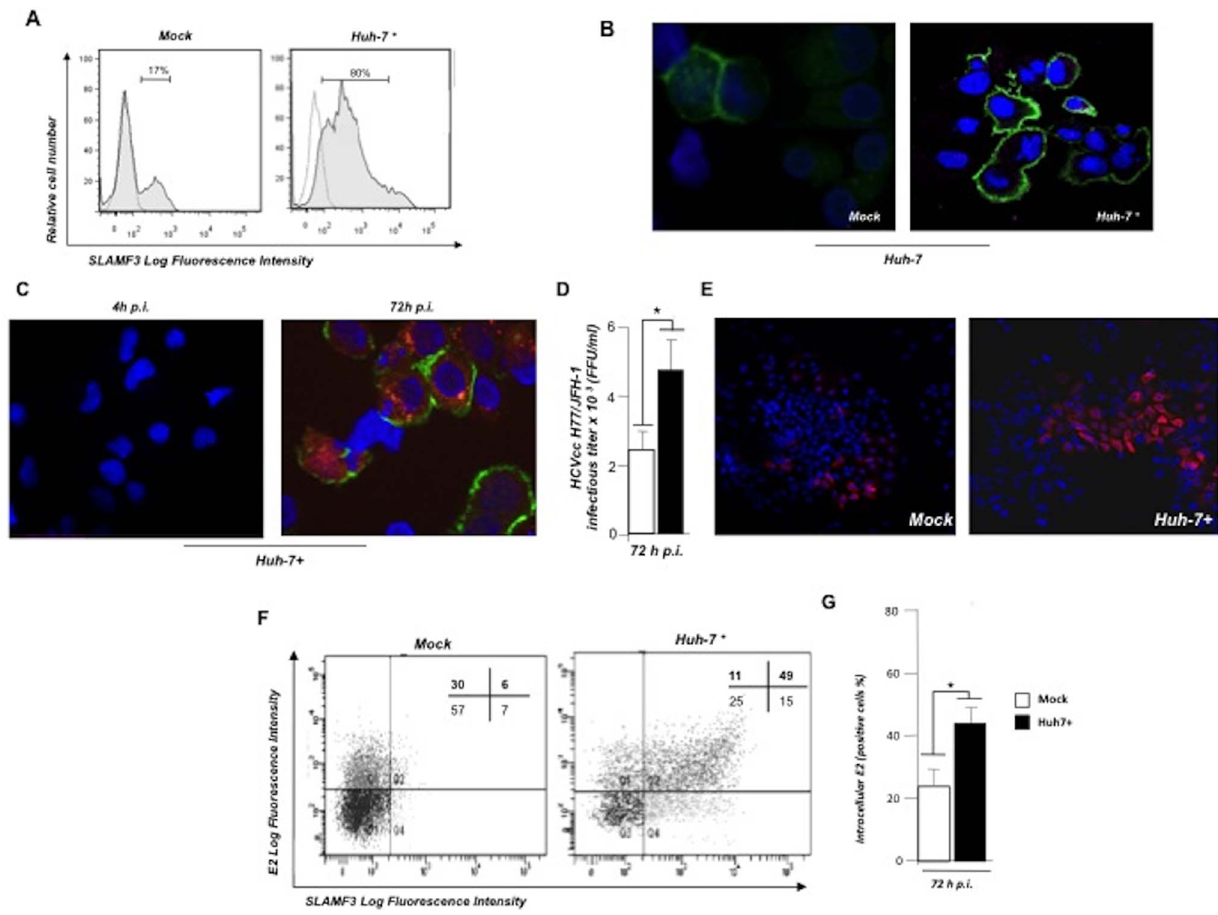
Figure 4. SLAMF3 over-expression increases hepatocyte permissiveness to HCV. Huh-7 cells were transfected with empty vector pBud (mock) or human SLAMF3 (to yield Huh-7 + cells) and incubated with HCVcc. (A) SLAMF3 expression was analyzed by flow cytometry (HLy9.1.25 clone) and (B) visualized by confocal microscopy in one out of three experiment. Unshaded histograms show the isotype-matched control (Co) and shaded histograms show SLAMF3 expression). (C, D, E) Infection was assessed at 4 and 72 h p.i. as the number of FFUs and (F and G) by flow cytometry analysis; (C) intracellular E2 (stained red) were measured at 4 h and 72 h p.i. Green staining corresponds to the SLAMF3 expression. One of three representatives independent experiments is shown. (D) The HCV permissiveness of Huh-7 mock and Huh-7 + cells was evaluated in terms of the number of FFUs based on intracellular E2 viral protein staining and (E) fluorescent microscopy analysis (mean of five experiments; error bars: SD; *p , 0.05); Infection evaluation by flow cytometry analysis measuring the intracellular viral E2. (F) Infected cells (72 p.i.) were stained for surface expression of SLAMF3 (HLy9.1.25 clone) and permeabilized for intracellular E2 staining. The percentage of positive cells in each cell population is indicated in the corresponding quadrant (one of three representative experiments is shown) and (G) as a mean of three experiments (error bars: SD; *p ,